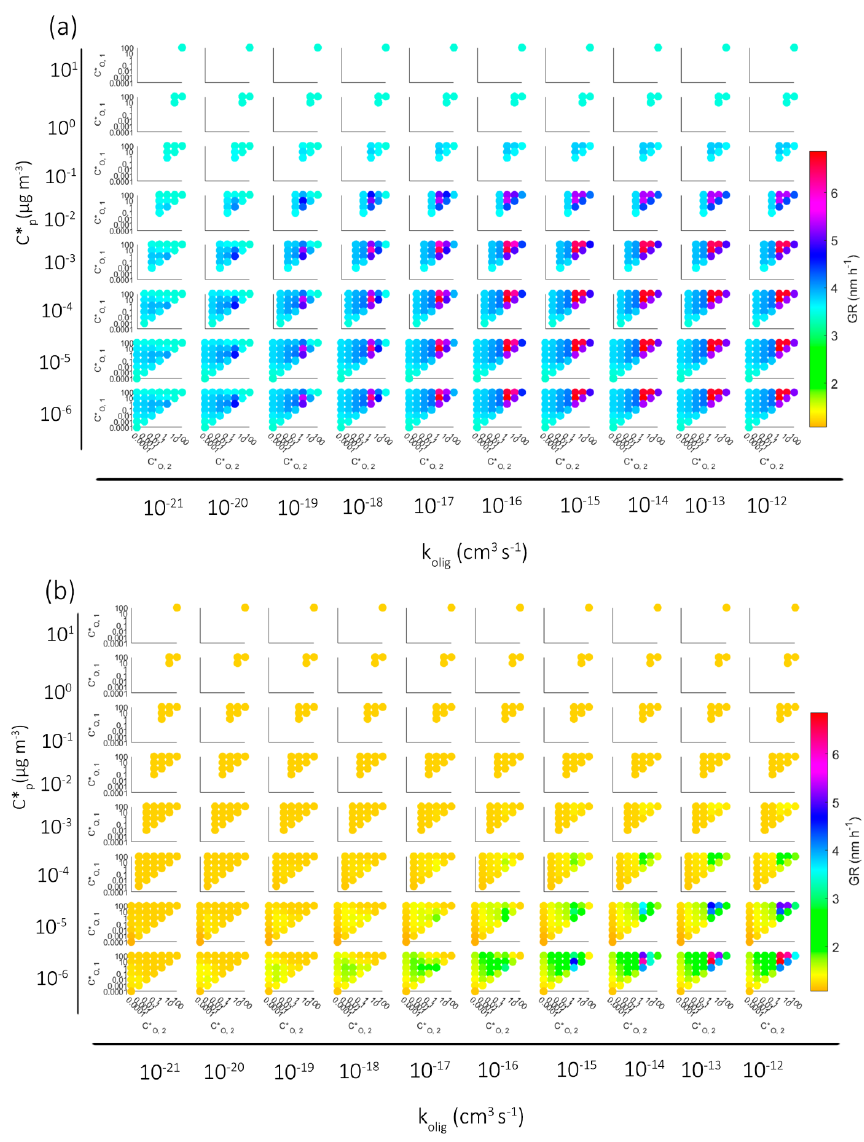
Figure 4. Growth rate of the particle in simulations with oligomerization for (a) particles over 5nm in diameter and (b) particles under 5nm in diameter. Each dot describes one simulation, and the color shows the corresponding growth rate. The growth rates are calculated assuming a linear growth curve. In the smaller figures the axes describe saturation concentrations of oligomerizing model compounds (µgm − 3 ). The wider horizontal axis describes the oligomerization rate coefficient in the simulation and the vertical axis the saturation concentration of the forming oligomerization